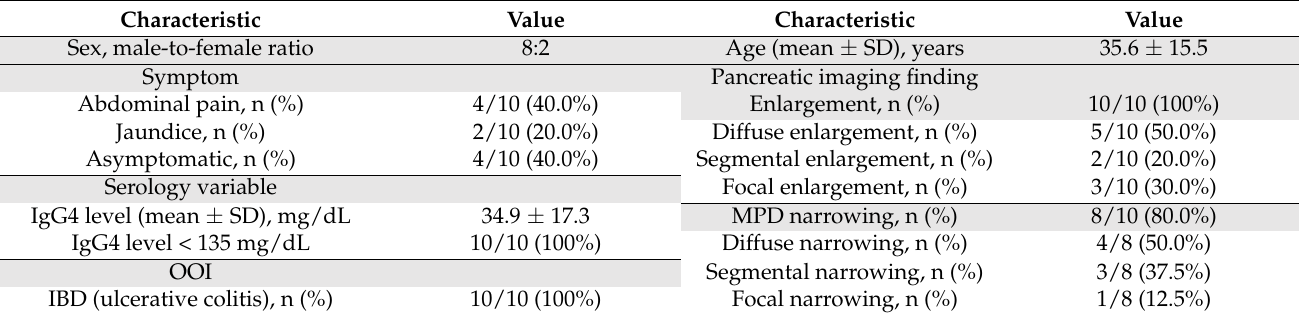
Table 1. Clinical characteristics of patients.